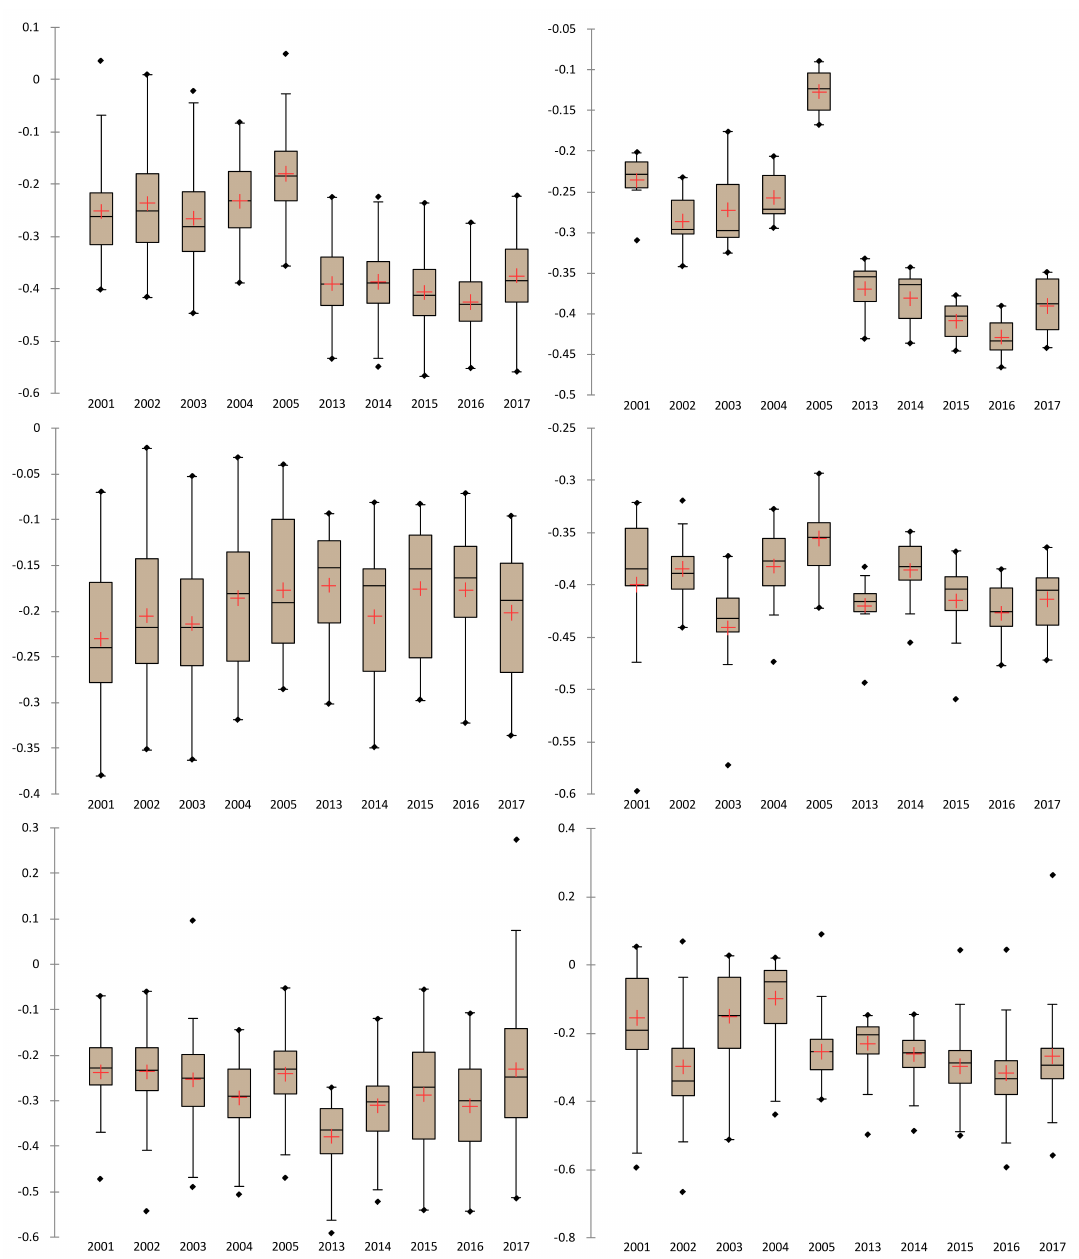
Figure 13. NDBaI boxplots for the six sites: Confluence ( top-left ), Kaplan Park ( top-right ), dock ( middle-left ), Garibadi street ( middle-right ), Museum ( bottom-left ), and Groupama Stadium ( bottom-right ); red cross: average; black dots: min and max